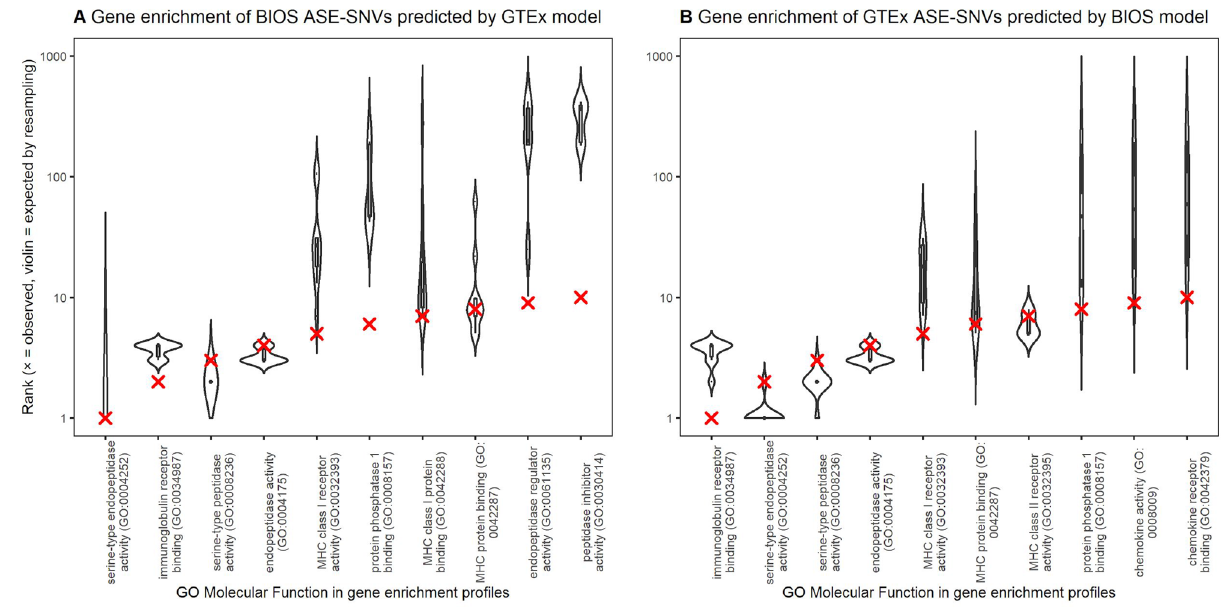
Figure 4. Bias test of BIOS and GTEx models. ( A ) Each violin represents the distribution of expected GO Molecular Function term ranks based on 10 × random resampling of BIOS ASE-SNVs using the same number of predicted ASE-SNVs. Each X indicates the observed rank of a GO Molecular Function term in the gene enrichment profile of BIOS ASE-SNVs correctly predicted by the GTEx model. For instance, the expected rank of endopeptidase activity (GO:0004175) lies around 3–4, and was observed at rank 4. ( B ) Each violin represents the distribution of expected GO Molecular Function term ranks based on 10 × random resampling of GTEx ASE-SNVs using the same number of predicted ASE-SNVs. Each X indicates the observed rank of a GO Molecular Function term in the gene enrichment profile of GTEx ASE-SNVs correctly predicted by the BIOS model. For instance, the expected rank of serine-type peptidase activity (GO:0008236) lies around 2, and was observed at rank 3. Plot was produced by R 70 version 3.3.0 using packages ggplot2 71 (v2.2.1), gridExtra (v2.3) and stringr